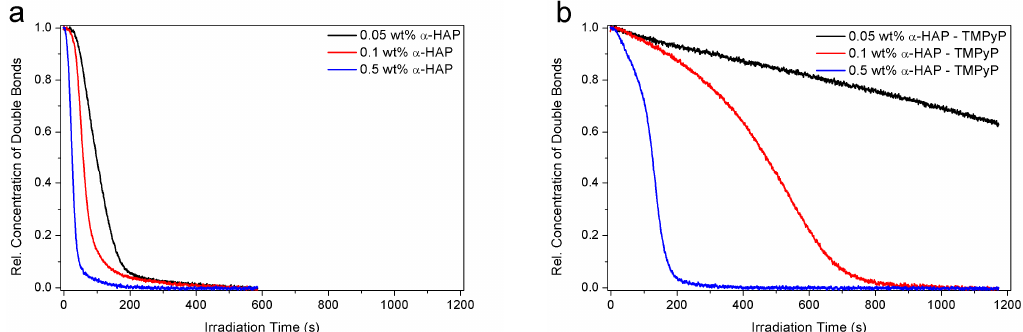
Figure 3. Photopolymerization kinetics of hydrogel formulations using three different α -HAP concentrations under atmospheric conditions and light intensity of 12 mW · cm − 2 : ( a ) without dye and ( b ) with TMPyP at 0.01 wt %.